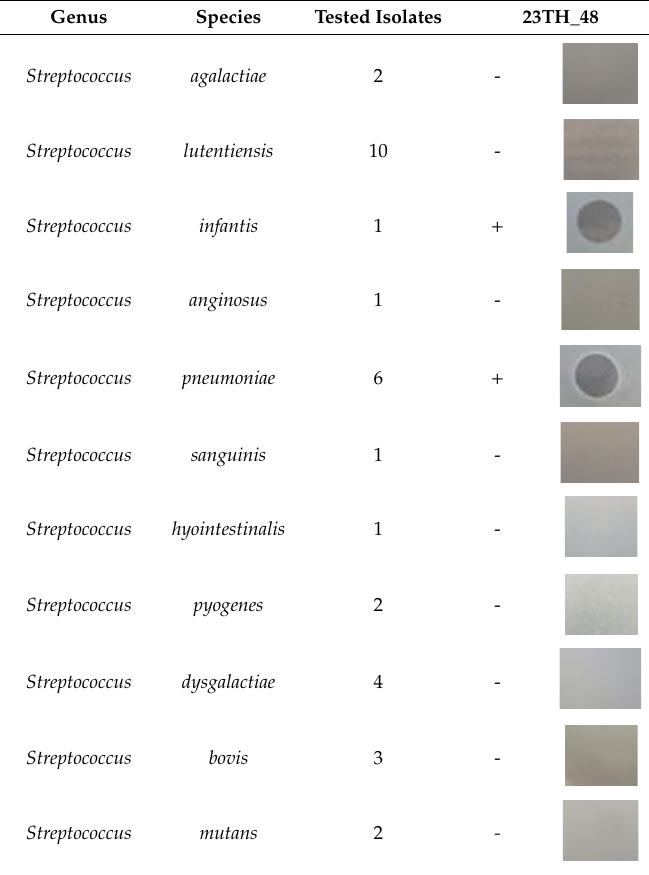
Table 1. Host range of lysin 23TH_48 tested by spotting on bacterial lawns. Genus Species Tested Isolates 23TH_48